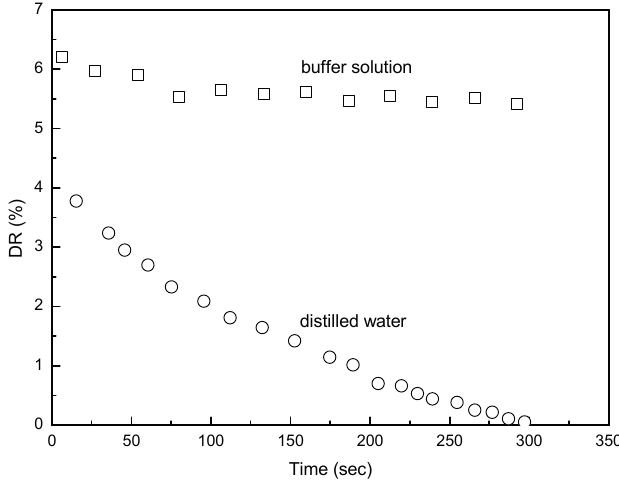
Figure 13. Difference between measured %DR of 1.35 wppm λ -DNA at Re = 7 × 10 5 in buffer solution and distilled water (Reprinted from